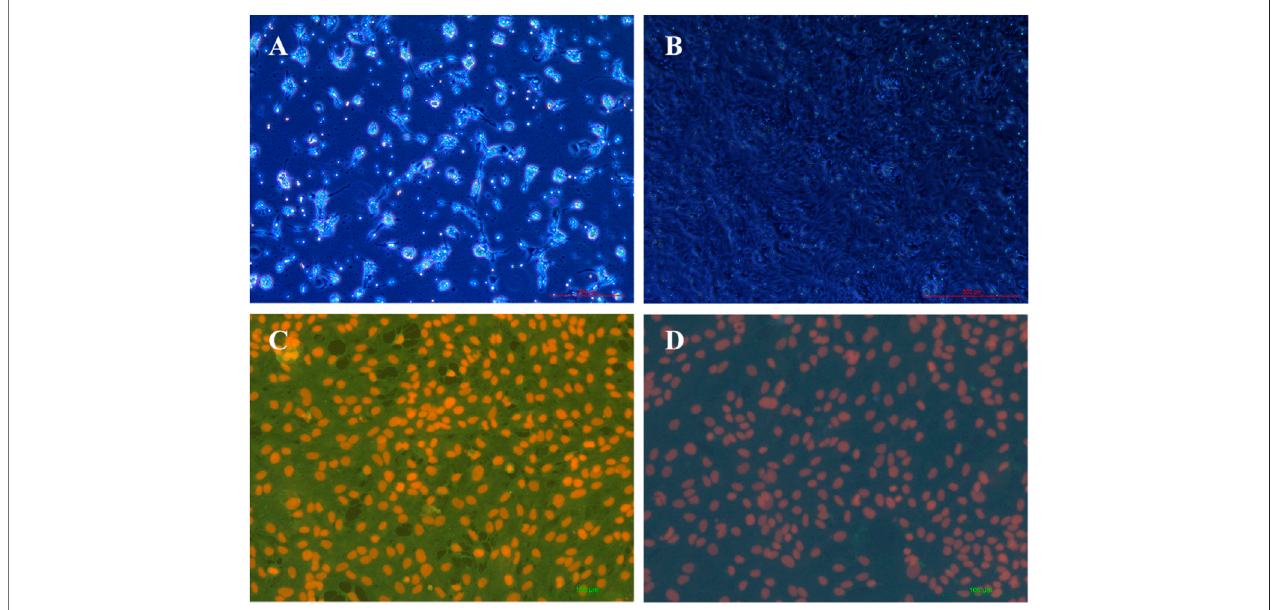
FIGURE 7 | Characterization ofrBMECs under a microscope. (A) rBMECs at 2 d, number of microvascular segments that appeared like astring of beads, and the wall of the tube was smooth and clear, (B) con fl uent subcultured cells formed cobblestoned morphology, (C) staining by factor VIII of cells, and (D) negative control.